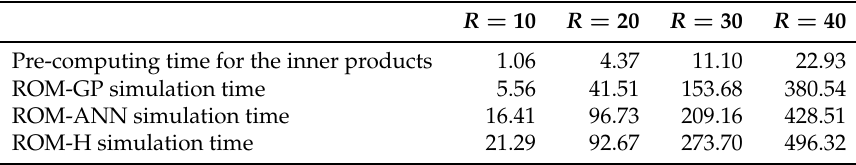
Figure 14. Time series evolution of the tenth modal coefficient, a 10 ( t ) , between t = 15 and t = 60 for FOM projection and different ROM approaches (ROM-GP, ROM-ANN, and ROM-H) with varying Re (Re = 25,100,400) and POD modes ( R = 10,20,30,40). Table 3. The computational CPU time in seconds required for ROM simulations between t = 15 and t = 60. Note that the FOM simulation is 4.82 h and offline POD basis generation takes about 23.38 min. The offline training time for ANN is less than one second due to the extremely fast ELM approach. R = 10 R = 20 R = 30 R =